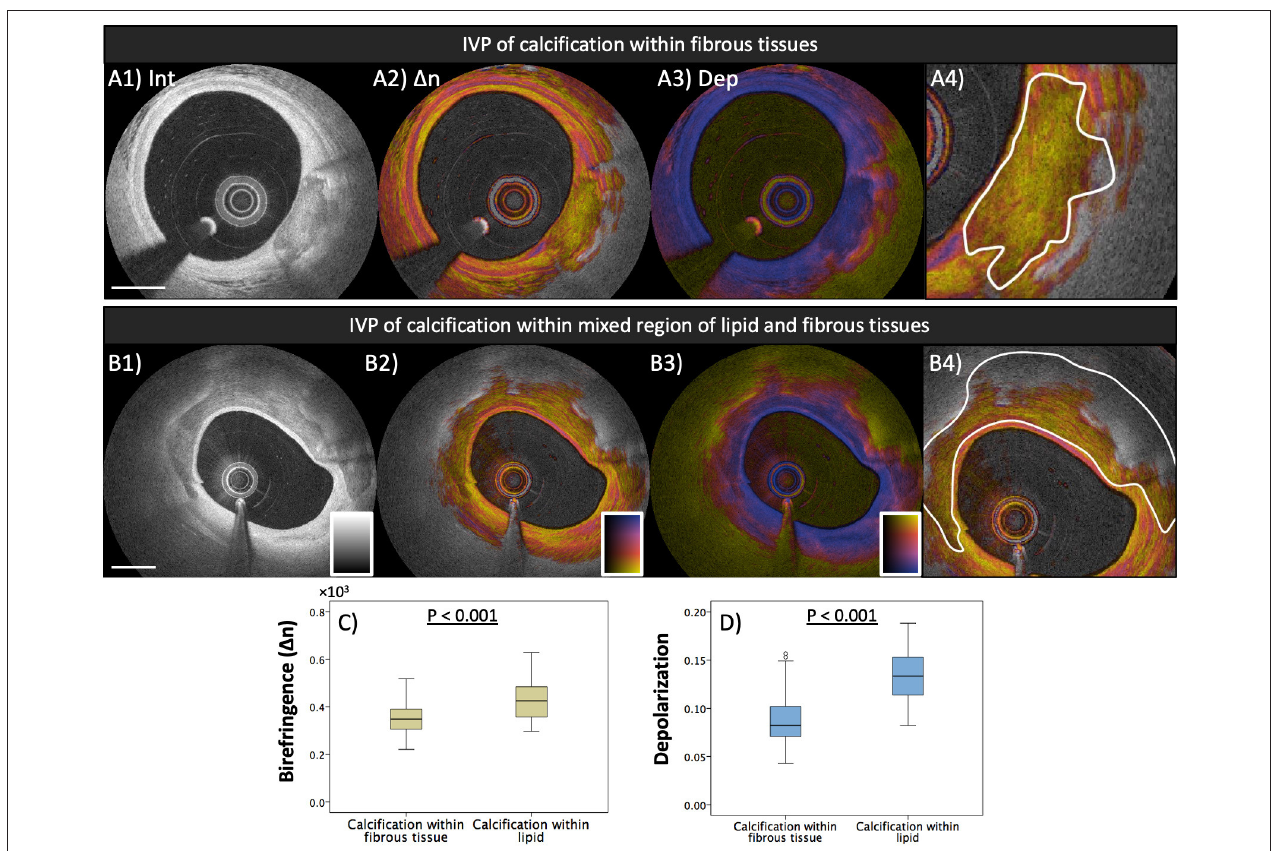
FIGURE 3 | Polarization properties of calcification. Median birefringence and depolarization were measured in calcified areas, manually segmented in the intensity images. Segmented areas were classified according to the presence or absence of lipid in the surrounding lesion (calcification within fibrous tissue or calcification within lipid). (A1–A4) IVP of calcification in fibrous tissue and segmentation of the calcified area. (B1–B4) Calcification in lipid-rich tissue. (C) Calcified areas in fibrous tissue exhibit lower birefringence than those in lipid-rich lesions ( p < 0.001). (D) Higher depolarization was observed in calcified areas in lipid-rich tissue than in those located in fibrous tissue ( p < 0.001). Adapted from Otsuka et al. (